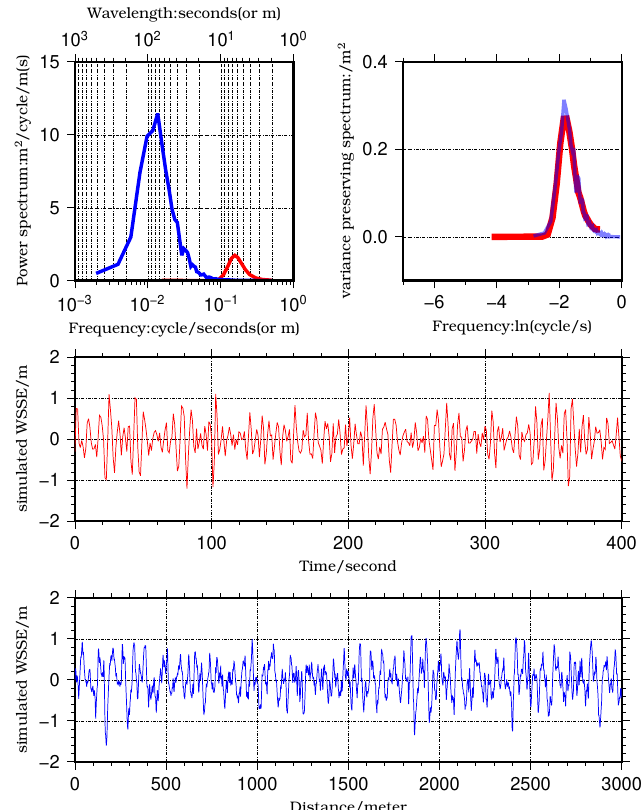
Figure 11. Simulated WSSE and its associated spectrum. The red (blue) line is the WSSE series in the time (space) domain. The upper-left image presents the nonunified PSD in the time/space domains. The upper-right image shows the unified VPS in the time